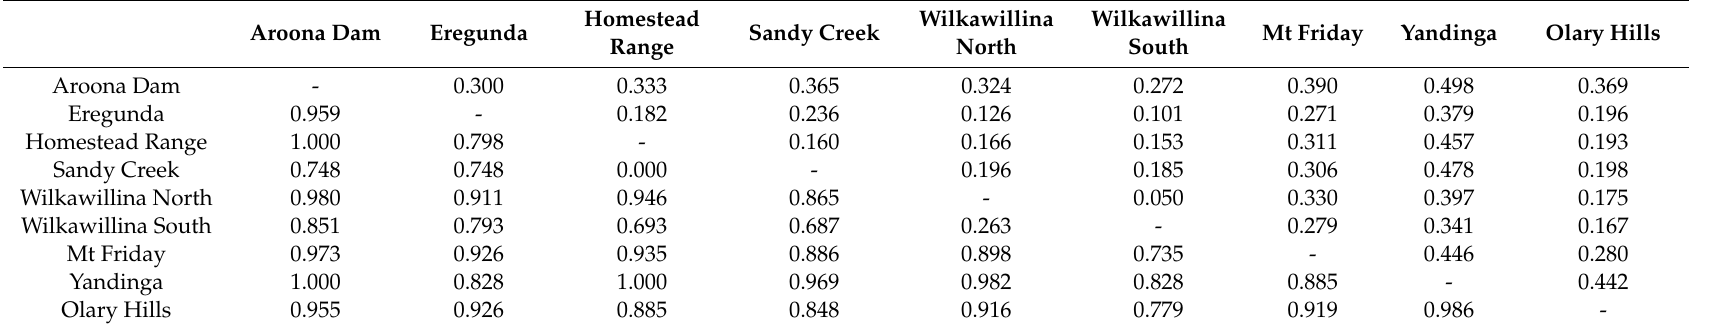
Table 3. Genetic di ff erentiation between populations of Petrogale xanthopus xanthopus with F ST values above the line and Φ ST values below the line. Significantly di ff erent populations are highlighted in bold. Two populations, Mt Stuart and Middle Gorge, were not included due to small sample size ( N = 2 /